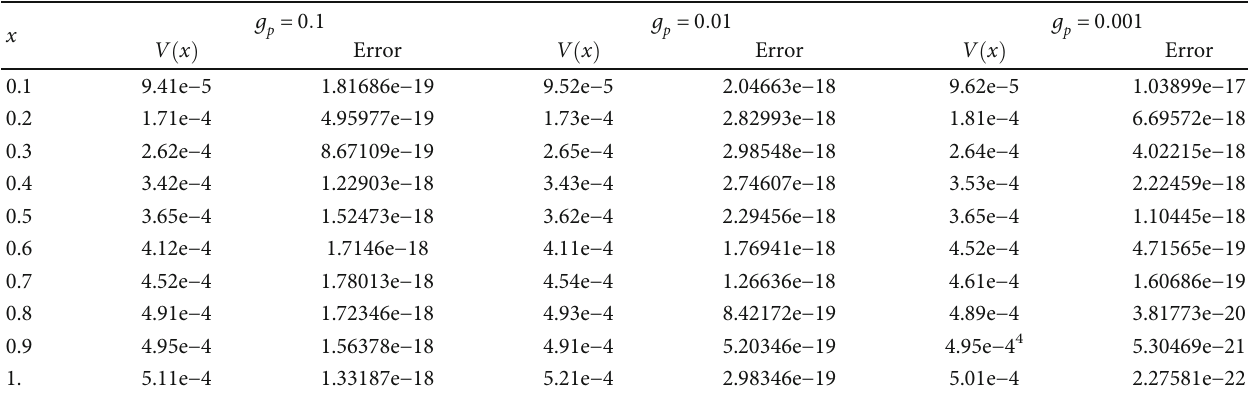
Table 4: Results for α in drainage case keeping β = 0 : 1 and g